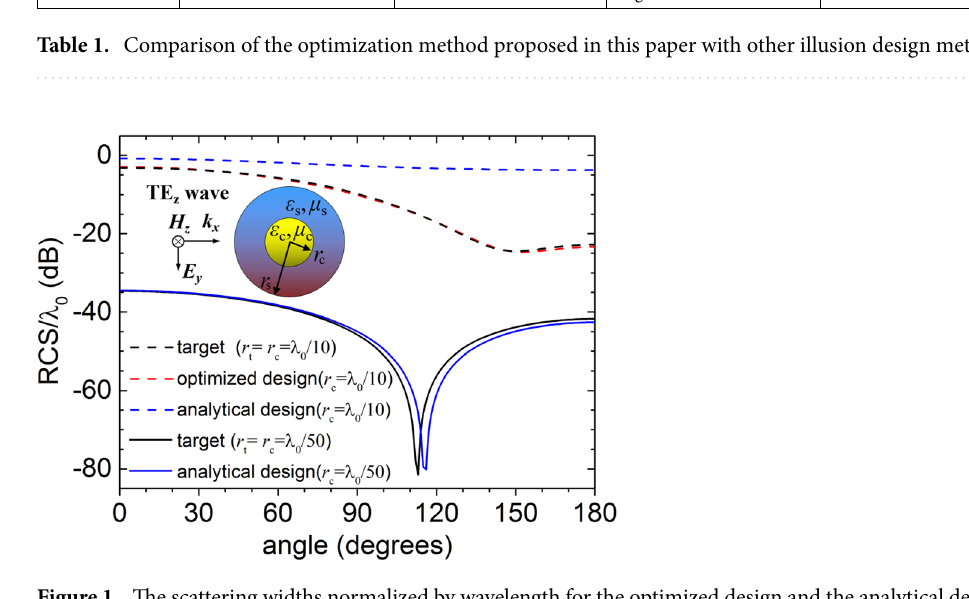
Figure 1. The scattering widths normalized by wavelength for the optimized design and the analytical design. Two different radii of the core are considered, namely r c = λ 0 /10 (dashed lines) and r c = λ 0 /50 (solid lines). We assume that the radii of the core and the target are equal, that is r t = r c . The constitutive parameters of the core and the target are (3